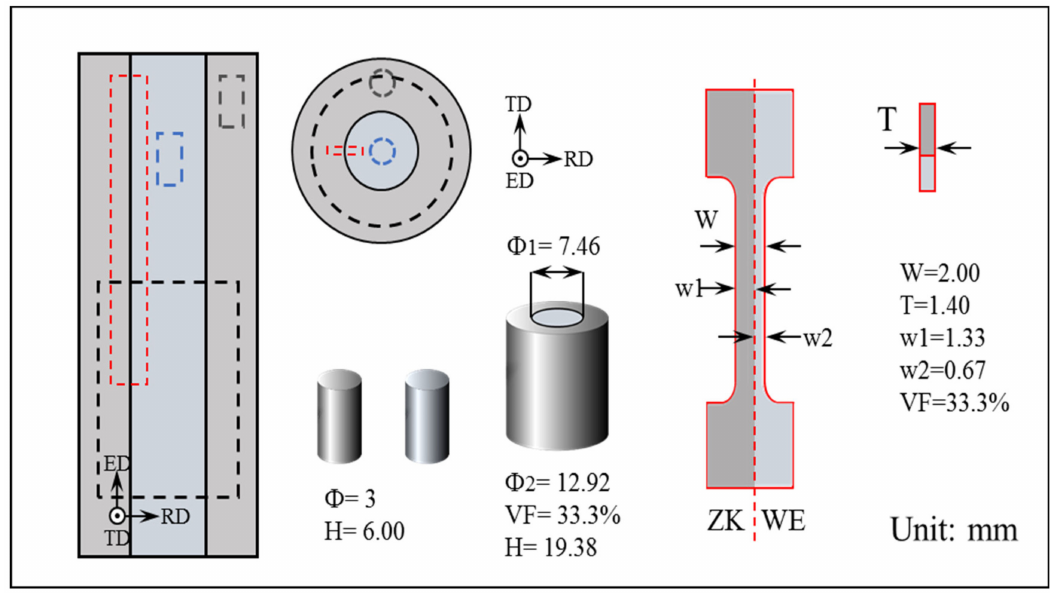
Figure 1. Schematic diagram showing the specimens for compressive and tensile